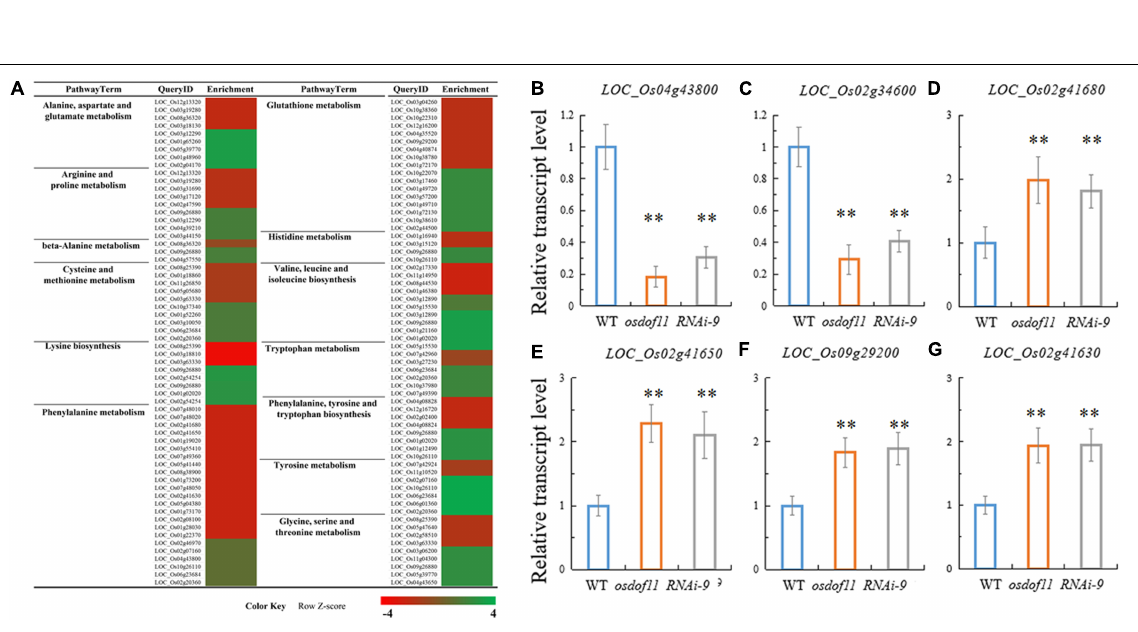
FIGURE 4 | Microarray analysis of related genes in WT and OsDOF11 mutants. (A) Microarray analysis; (B) Down regulated genes; (C) up regulated genes; (D) down regulated genes related to amino acid metabolism; (E) Up regulated genes related to amino acid metabolism.